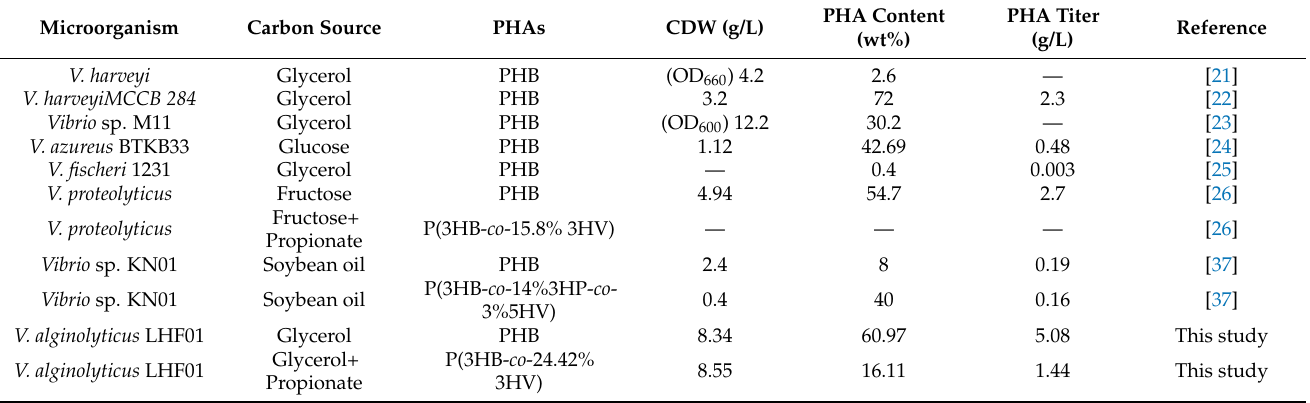
Table 4. PHA production by Vibrio